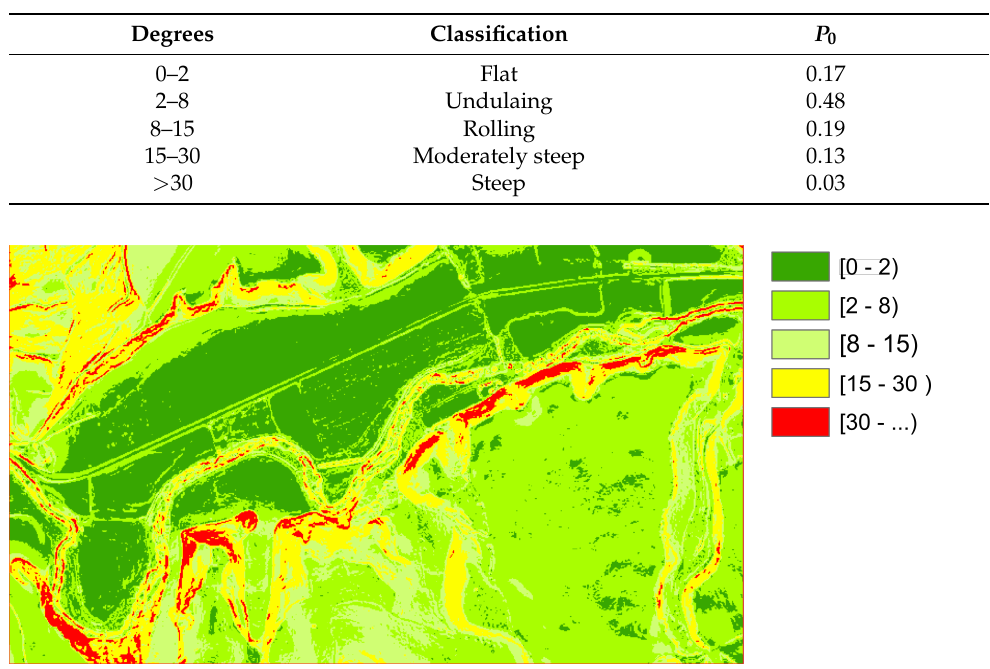
Figure 5. Classification of slopes: Case #1 (example in the sub-area shown in Figure 2). Table 8. Classification of slopes: Case #2.